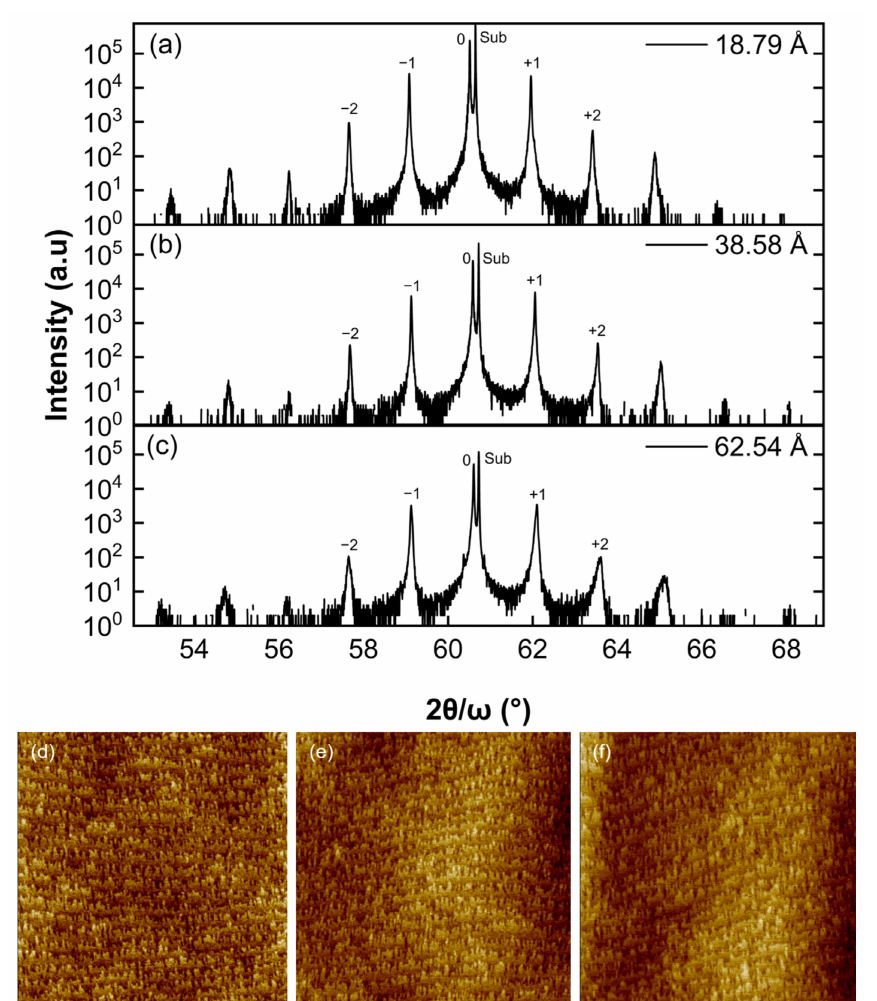
Figure 8. HRXRD rocking curve was obtained using epitaxial superlattices on substrates with three different native oxide layer thicknesses; the AFM images in the 1 × 1 µ m range of ( d ), ( e ), and ( f ) correspond to ( a ), ( b ), and ( c ) respectively; ( d ) the surface RMS was 0.116 nm with a native oxide layer thickness of 18.79 Å; ( e ) the surface RMS was 0.144 nm with a native oxide layer thickness of 38.58 Å; ( f ) the surface RMS was 0.171 nm with a native oxide layer thickness of 62.54